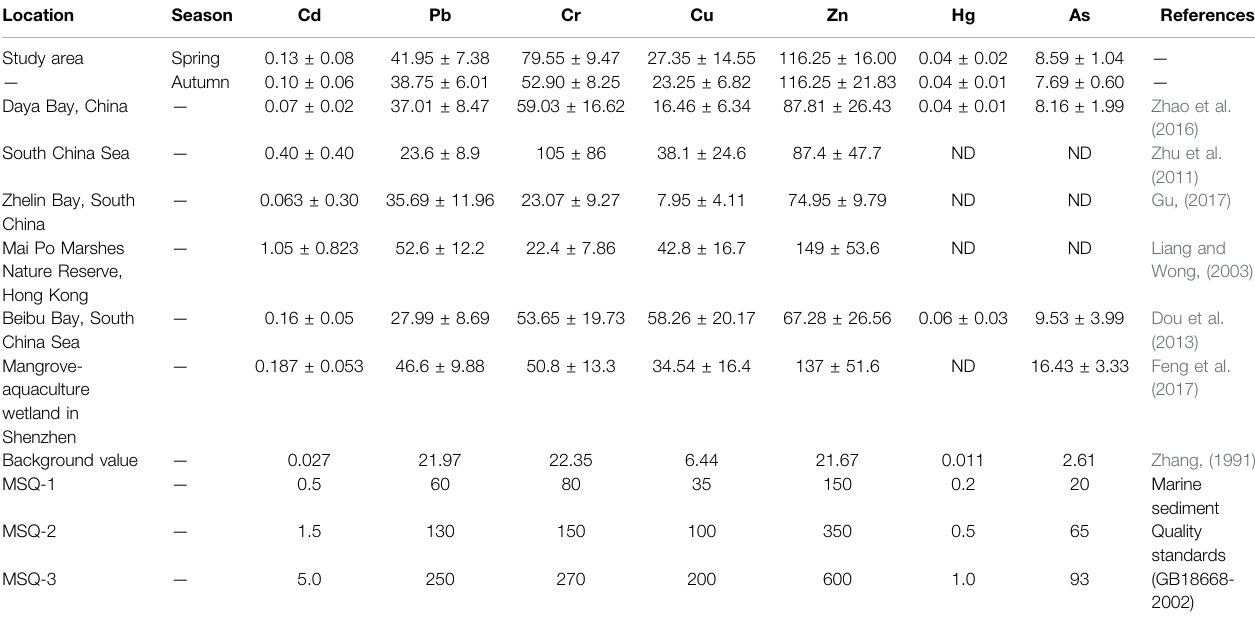
TABLE 2 | Concentration (mg/kg) comparative summary for heavy metals in surface sediment of the research region and other relevant areas.